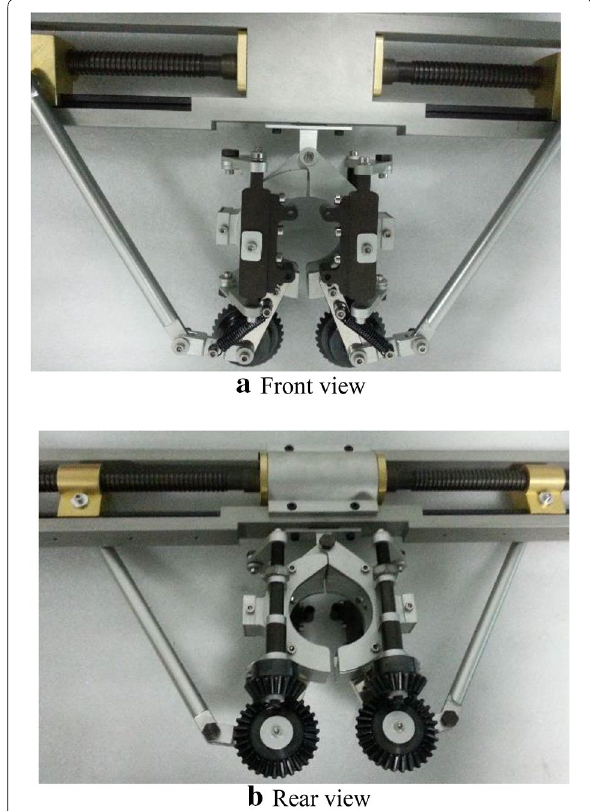
Figure 19 Prototype of repositioning metamorphic mechanism (This figure is reprinted with permission from Ref. [26], Copyright (2015)